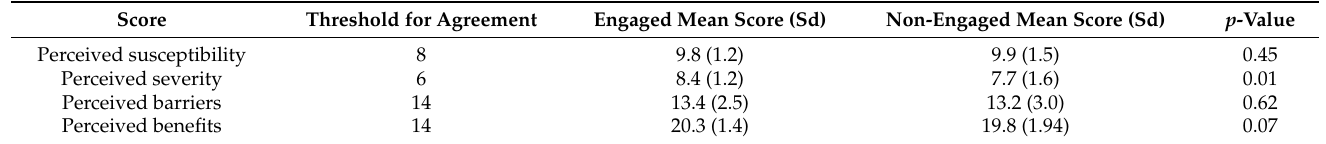
Table 3. Mean scores for Health Belief Model concepts by engaged and non-engaged